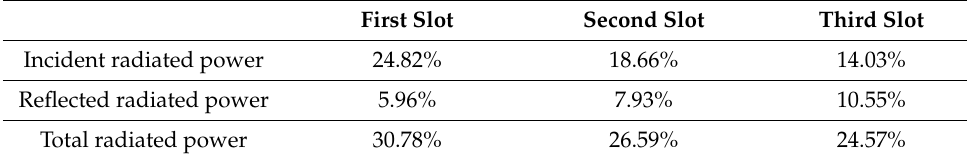
Table 2. Percentage of radiated power per